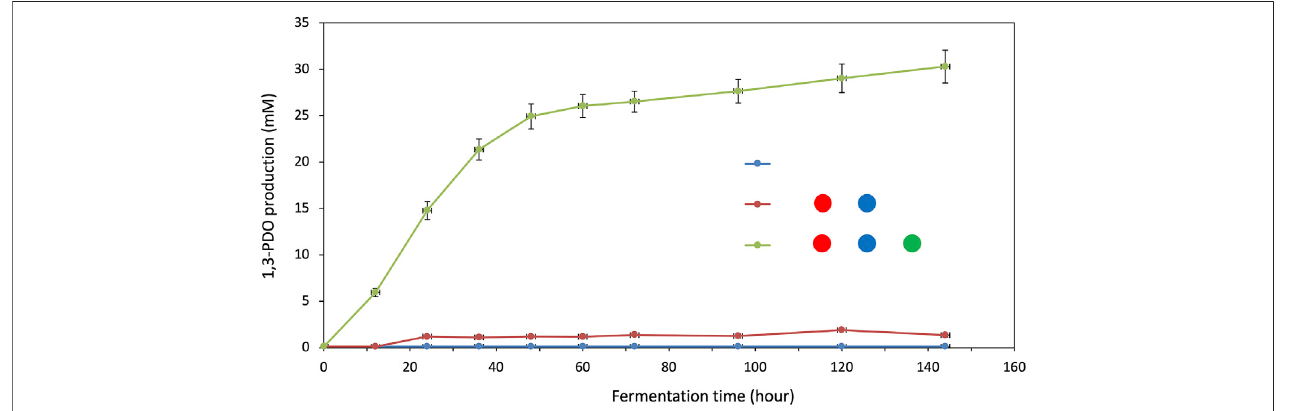
FIGURE 2 | Baseline production of 1,3-PDO in E. coli using enzymes from C. butyricum and determination of the contribution of E. coli YqhD to 1,3-PDO production. All symbols are described in Figure 1 . Standard deviation is shown as vertical bars for each data